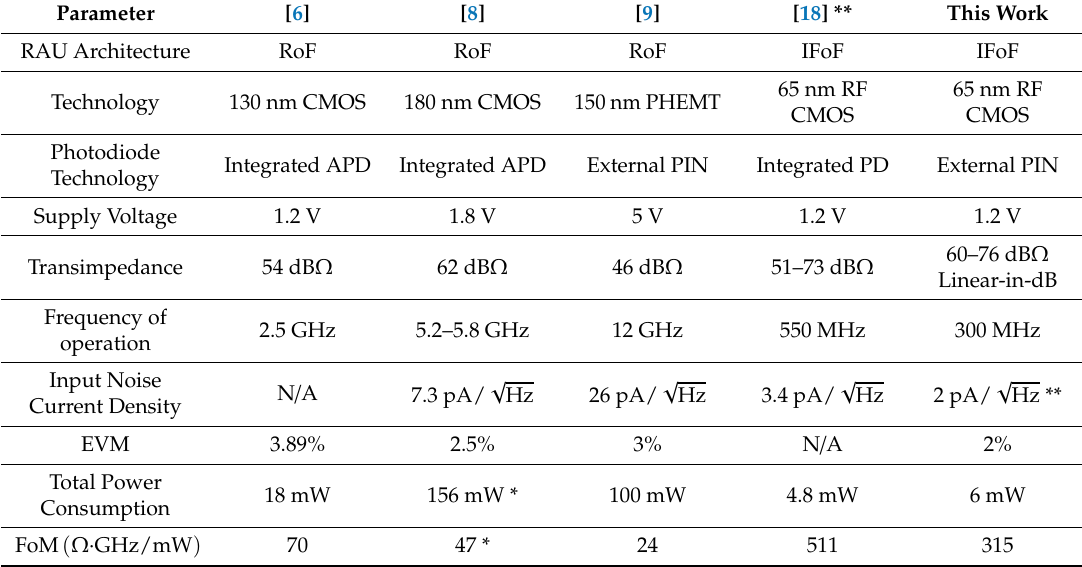
Figure 10. ( a ) Frequency response of the electro-optical front end. The BW is maintained almost constant at around 300 MHz and ( b ) output signal error vector magnitude using the demodulation of a 54 Mb/s 802.11a WLAN signal. Table 1. Summary of measurement results and comparison with RF transimpedance amplifiers.